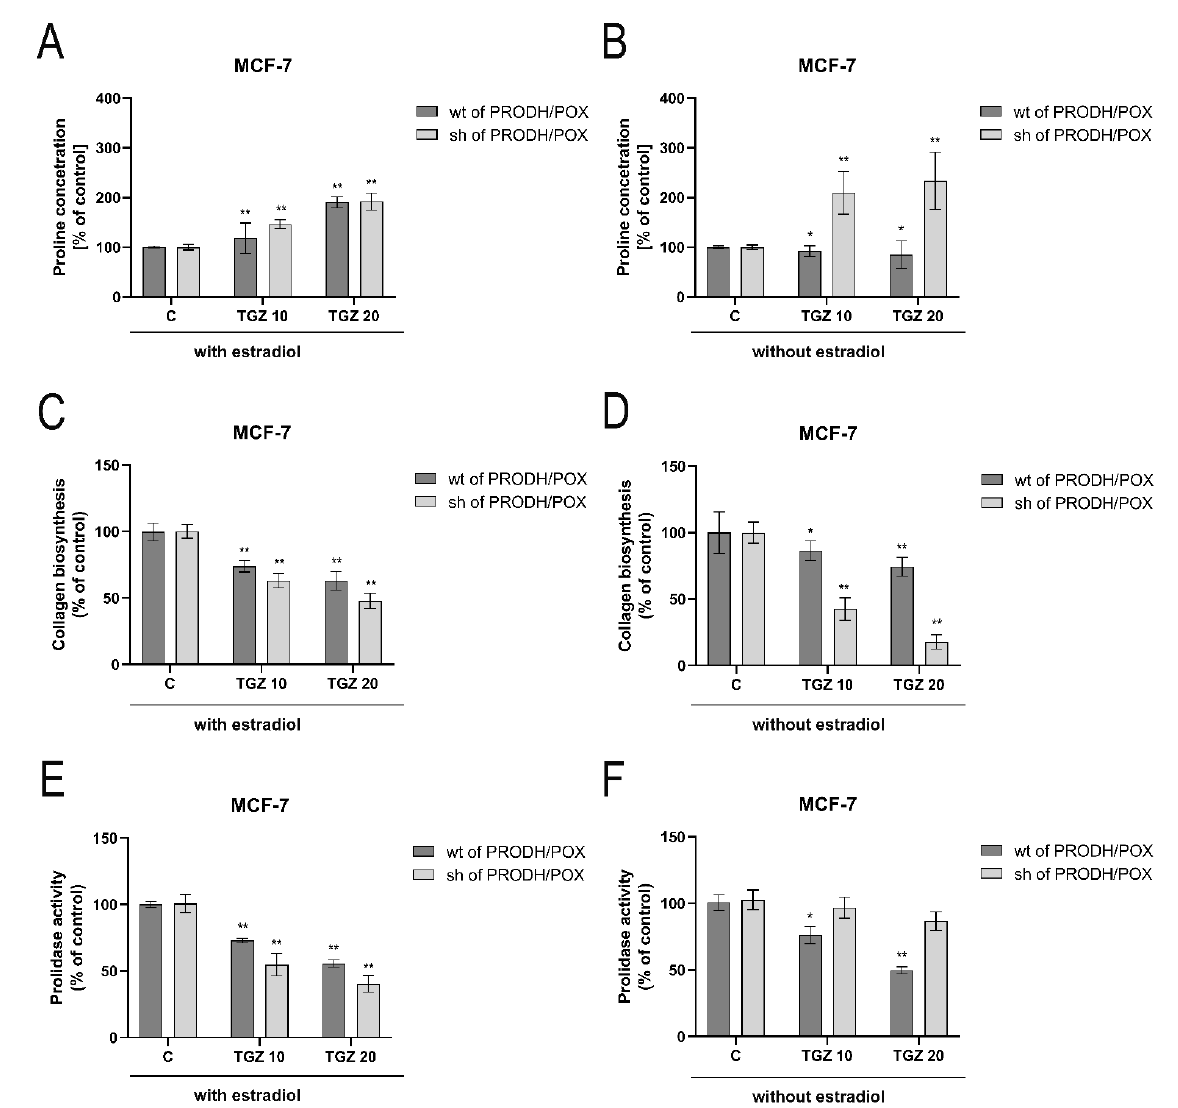
Figure 5. Proline concentration ( A , B ), collagen biosynthesis ( C , D ) and prolidase activity ( E , F ) in wild type (wt of PRODH/POX) and PRODH/POX-silenced (sh of PRODH/POX) MCF-7 cells stimulated by troglitazone (TGZ) for 24 h in the presence ( A , C , E ) and absence ( B , D , F ) of estradiol. The mean values ± standard deviation (SD) from 3 experiments done in duplicates are presented. Asterisks (*) indicate statistical differences between studied cells compared to controls at * p < 0.01 and ** p < 0.001.